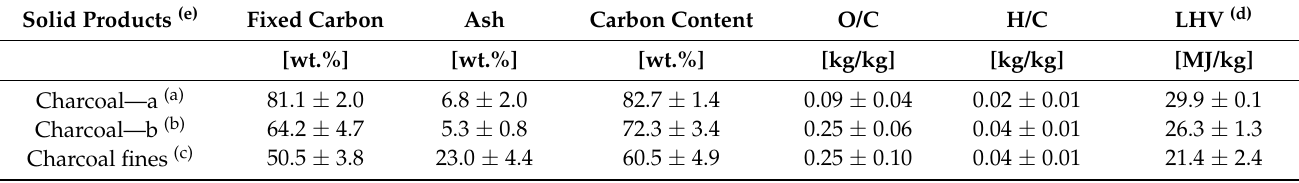
Table 3. Characteristics of charcoal and charcoal fines as recovered from inside the kiln in the aftermath of the carbonization